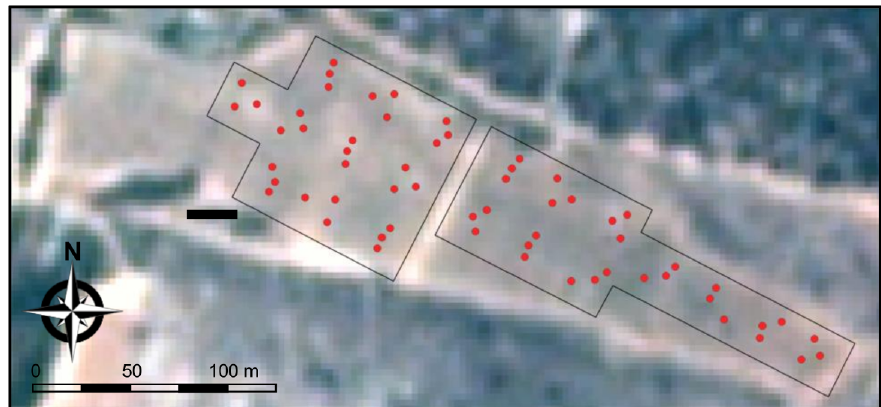
Figure A1. A true RGB color Planet image (from 3 June 2016) of Mevo Beitar vineyard with location of the 60 Ψ stem measurement